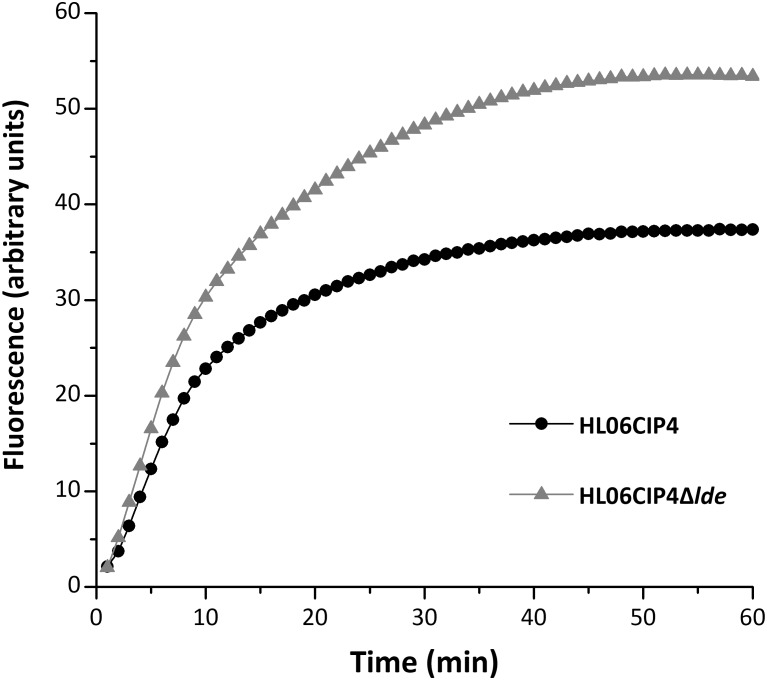
Accumulation of EtBr by HL06CIP4 and HL06CIP4Δlde.